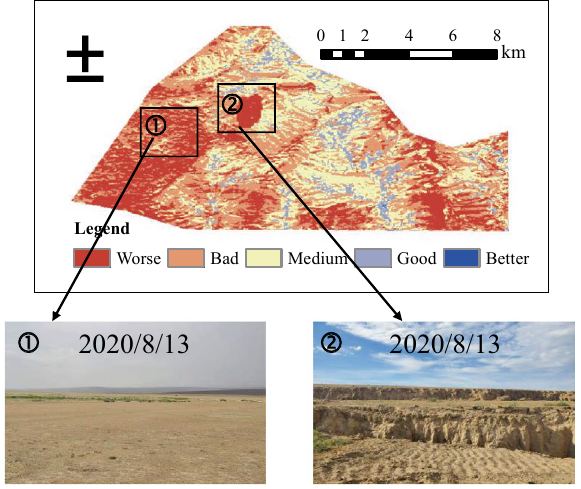
Figure 6. Eco-environmental quality grading for Ili No. 4 Coal Mine and eco-environmental problems, ➀ Surface subsidence and ➁ Vegetation degradation. The Figure is created using ArcGIS ver.10.2 (https:// www. esri. com/).